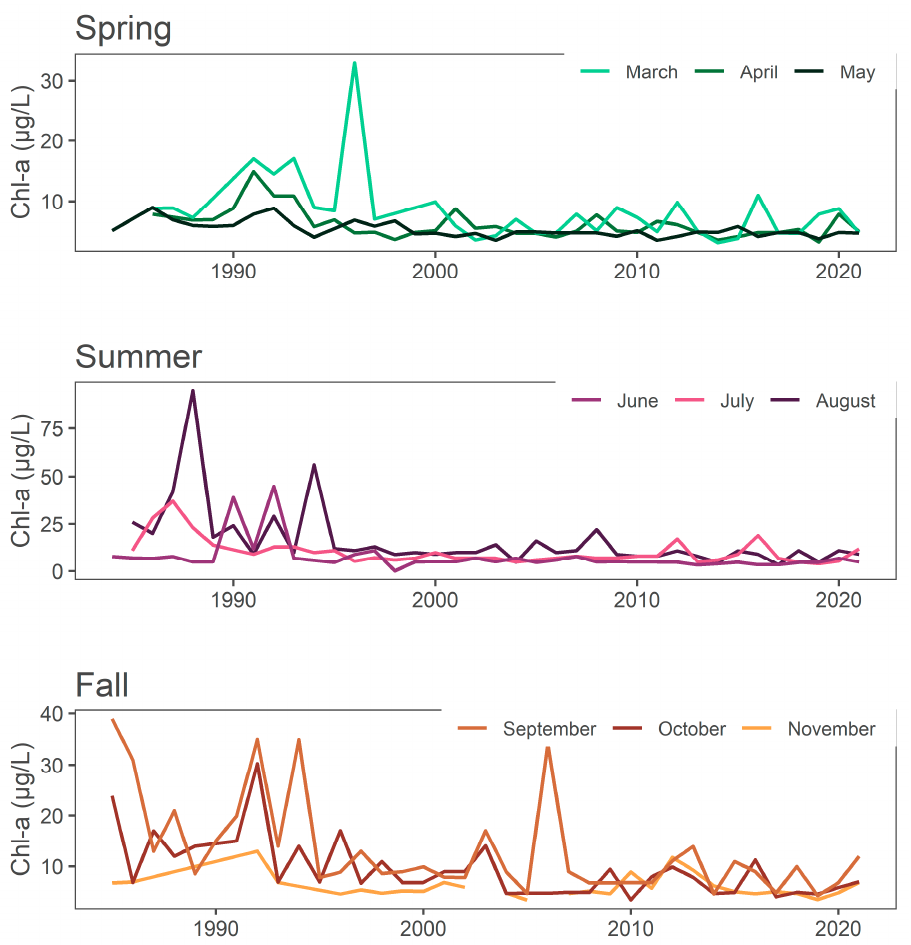
Figure 15. Time history of median chl-a by month and season for the study period. Note that the y-axes are not identical for each season.